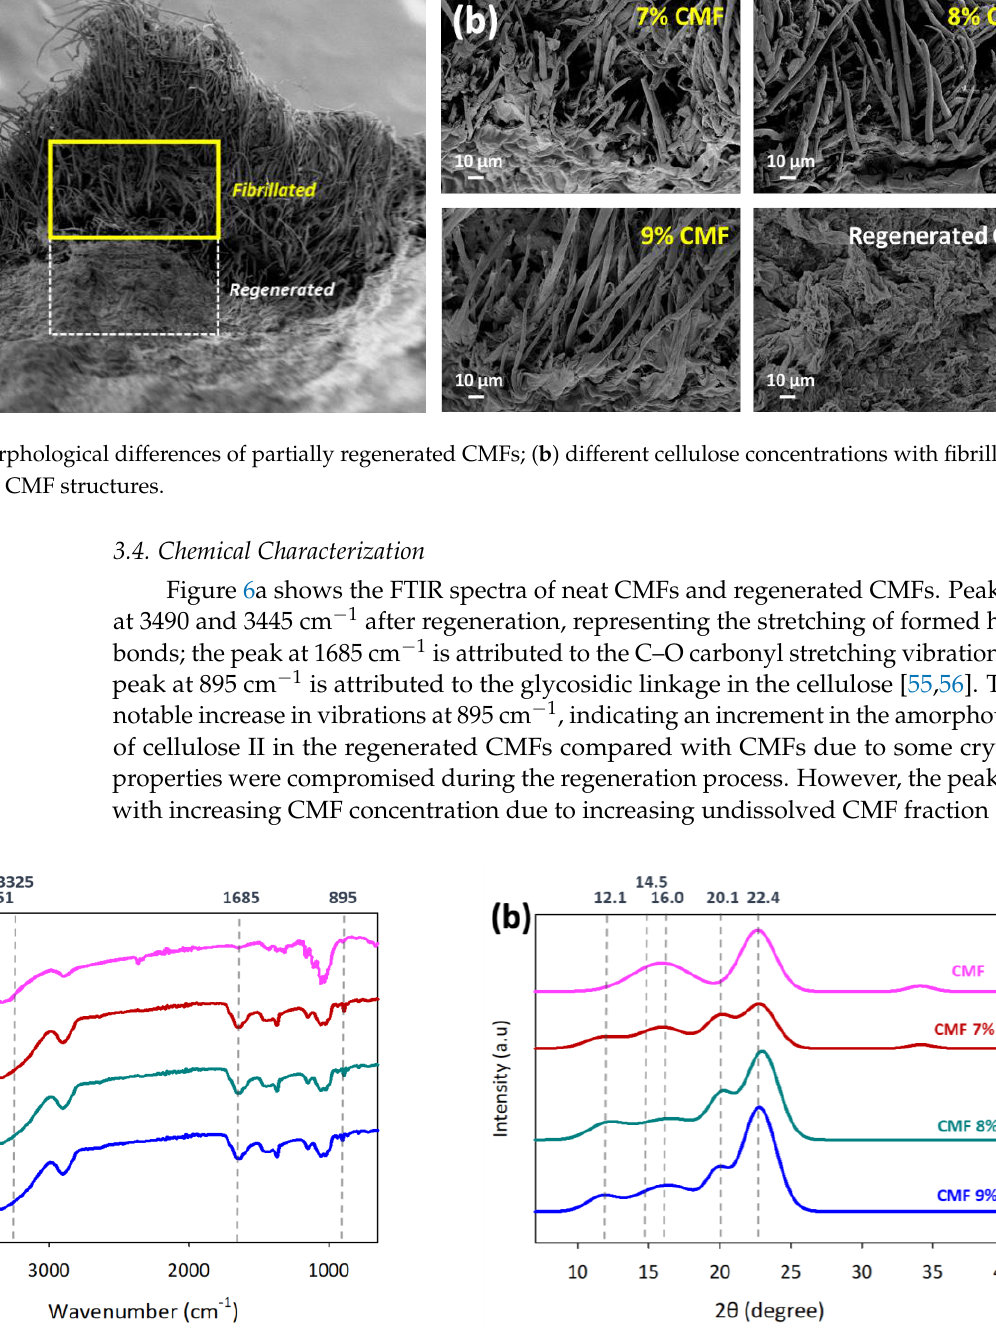
Figure 6. Chemical characterization of neat CMFs and 3D printed CMFs on ( a ) FTIR and ( b ) XRD at different CMF concentrations.